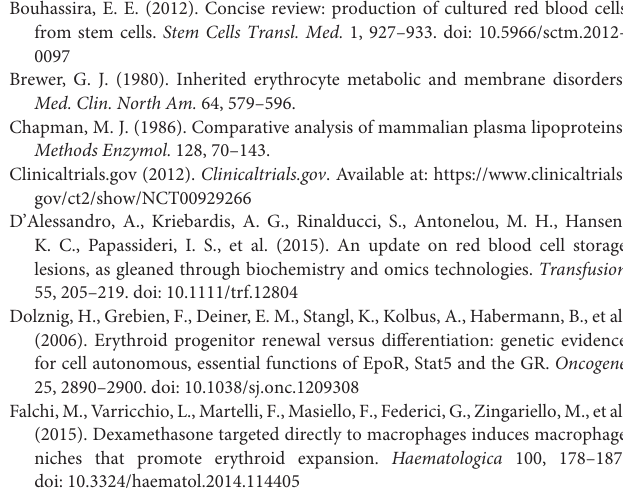
FIGURE S1 | Characterization of the lipoprotein fractions purified from human plasma investigated in the study. (A) Diagram of the purification scheme indicating the series of ultracentrifugations used for lipoprotein fractionation. ρ indicates the density of the original plasma or of infranates prepared for ultracentrifugation and is expressed as g/mL. (B) Commassie blue and silver staining of the proteins contained in the various lipoprotein fractions separated by gel electrophoresis. The numbers on the top indicate the amount of protein loaded. The position of the molecular weight markers is indicated in kDa on the left while the identity of the bands (predicted on the basis of their size) is indicated by arrows with the corresponding labels (Chapman, 1986). (C) Densitometric profile of the bands present in the lanes of the gel stained with Silver presented in (B) . FIGURE S2 | Design of the experiments used to evaluate the effects of lipid supplementation on erythroblasts expansion under HEMA def and HEMA ser conditions. As summarized in Supplementary Table S1 , end-points of these experiments were represented by expansion of erythroid (liquid cultures, Figure 3 ) and progenitor (semisolid cultures, Figure 4 ) cells over time and short-term proliferation ( Figure 2 ), ability to progress along the terminal maturation pathway ( Figure 5 ) and resistance to stress-induced autophagic death ( Figure 6 ). TABLE S1 | list of the end-points analyzed in our study and of their corresponding biological implications. TABLE S2 | Protein and lipid content of the lipoprotein fractions purified from human plasma used in the study. The expected protein/lipid and CH/TG ratios in each fraction on the basis of published data. TABLE S3 | Comparison of the composition of the home made and Sigma LDL